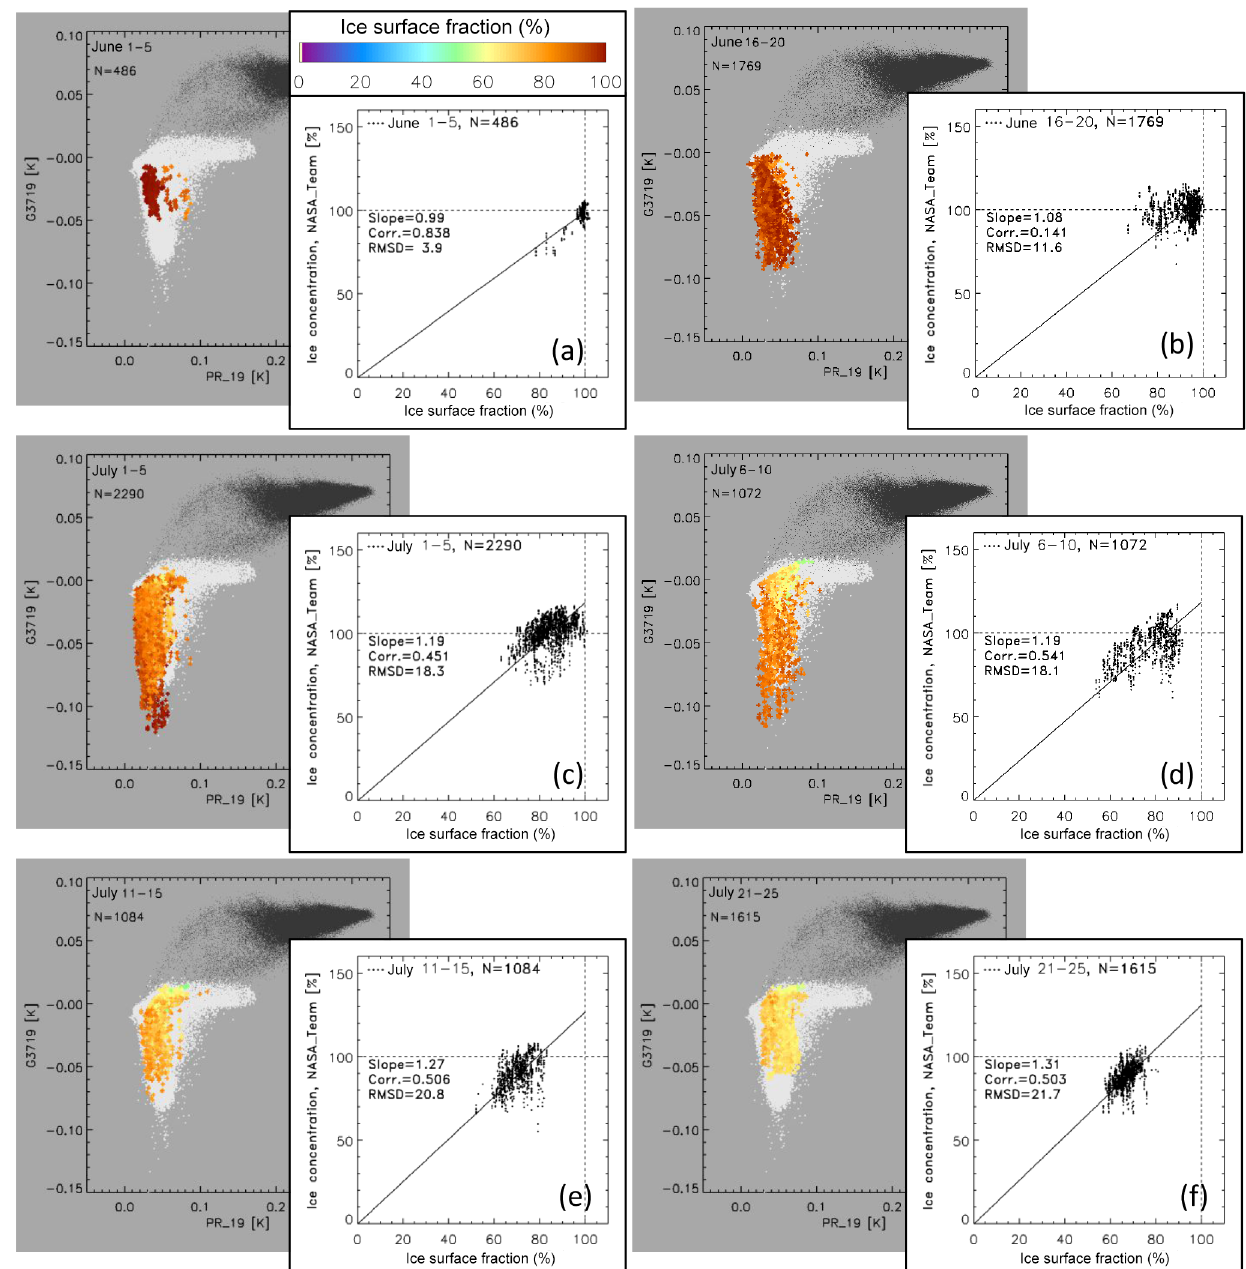
Figure 7. Background: AMSR-E brightness-temperature frequency difference (gradient ratio, GR) at 37 and 19GHz, vertical polarization, vs. AMSR-E brightness-temperature polarization difference (polarization ratio, PR) at 19GHz, color-coded with the co-located MODIS ice- surface fraction for six selected pentads denoted in the upper left corner of each image together with the number N of data pairs. For white and black dots, see Fig. 6. Foreground: NASA Team sea-ice concentration vs. MODIS ice-surface fraction for the same pentads together with the linear regression line forced through ( 0 , 0 ) . The slope of this line is given, together with the correlation between the two data sets and the root mean square difference (RMSD) of the two data sets in each